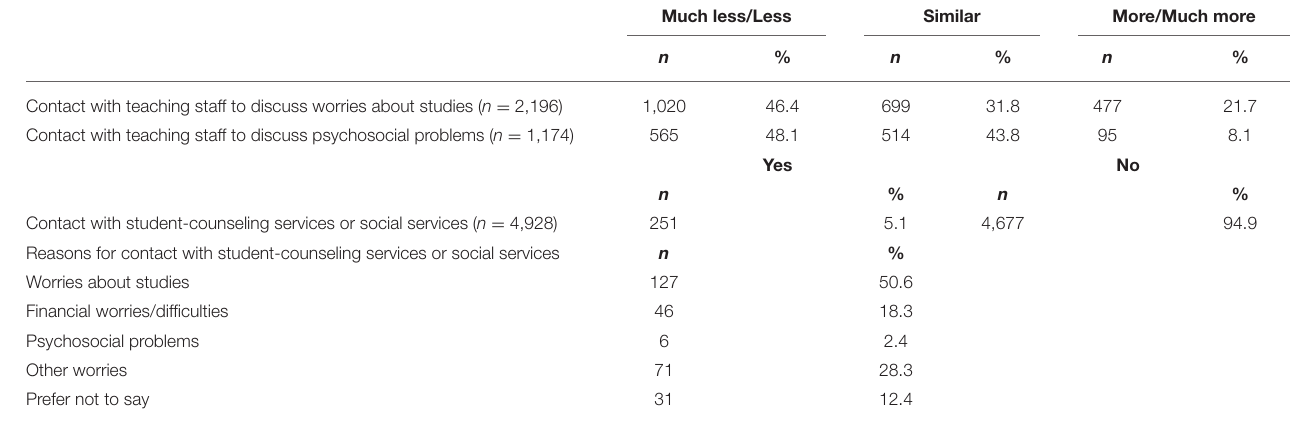
TABLE 4 | Frequency of contact with teaching staff and contact with student-counseling services or social services and reasons for contact (multiple